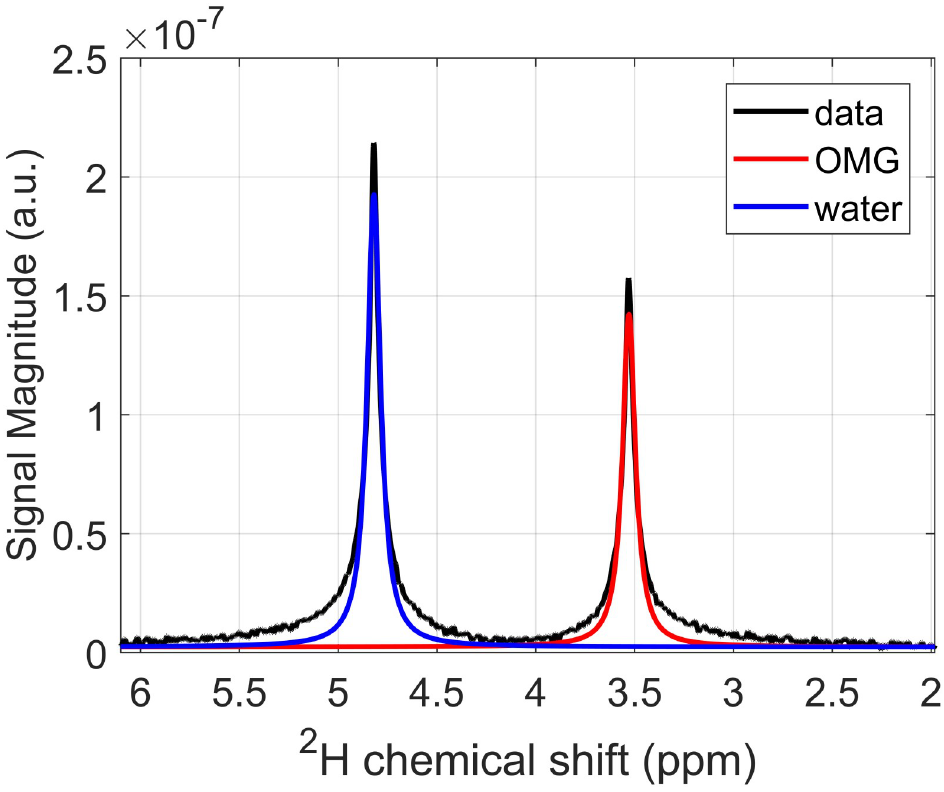
Fig 1. Deuterium spectrum of the OMG phantom. Deuterium spectrum of the spherical phantom containing 4.3 mmol/l OMG and distilled water. We assume a natural abundance of deuterium of 0.0156%. The chemical shift was determined to 3.51 ± 0.01 ppm. From a comparison of the peak areas, a degree of deuteration of 2.9 ± 0.1 deuterium atoms per OMG molecule could be estimated.